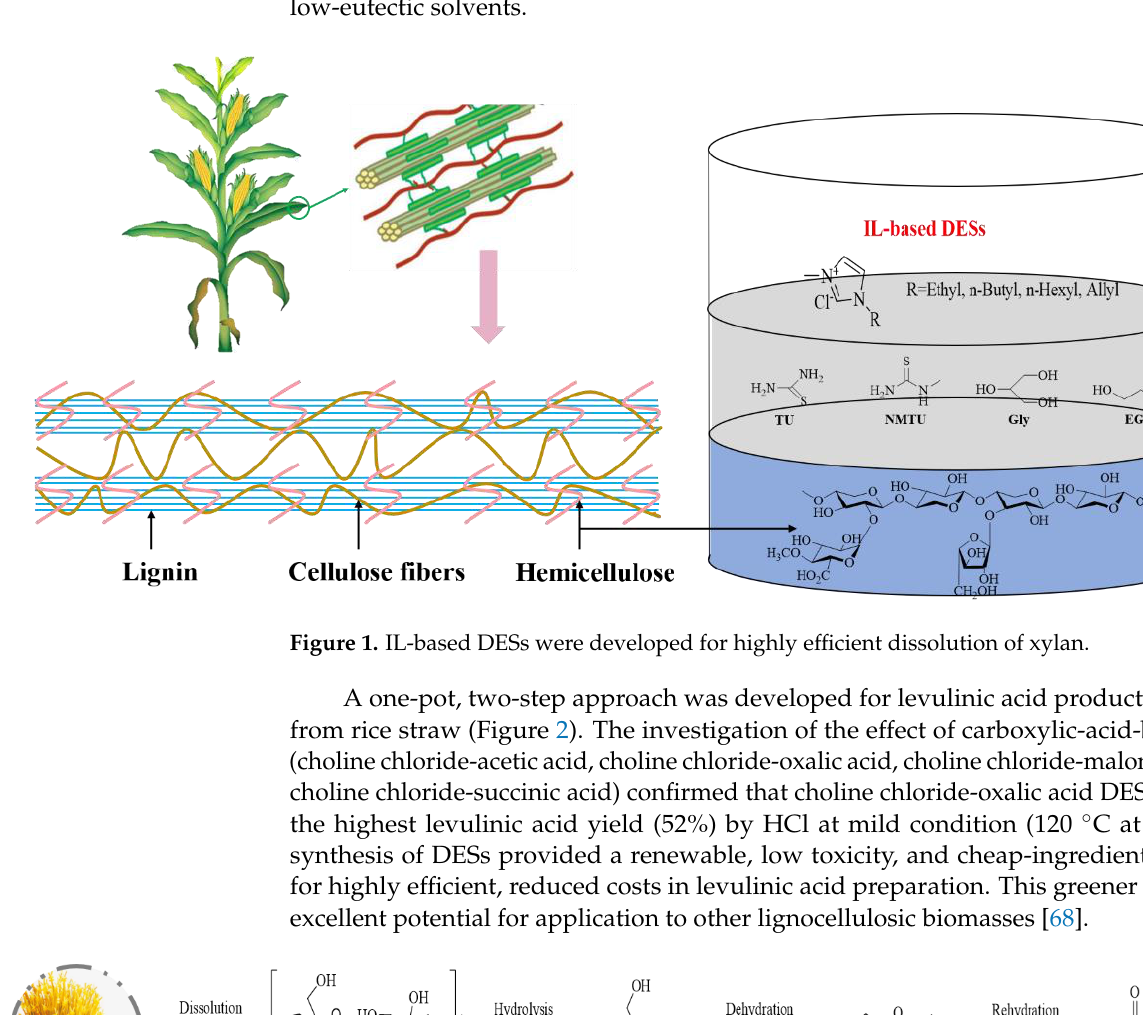
Figure 1. IL-based DESs were developed for highly efficient dissolution of xylan .